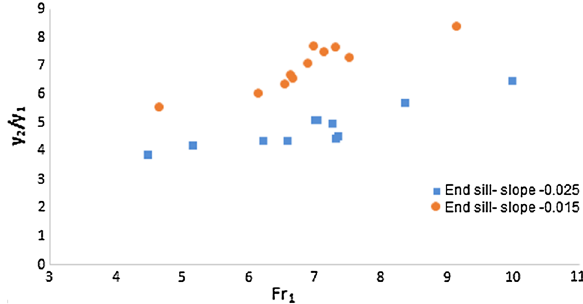
Fig. 4 Sequent depth ratio y adverse slope for two slopes S 0 = 0.015 and S 0 =